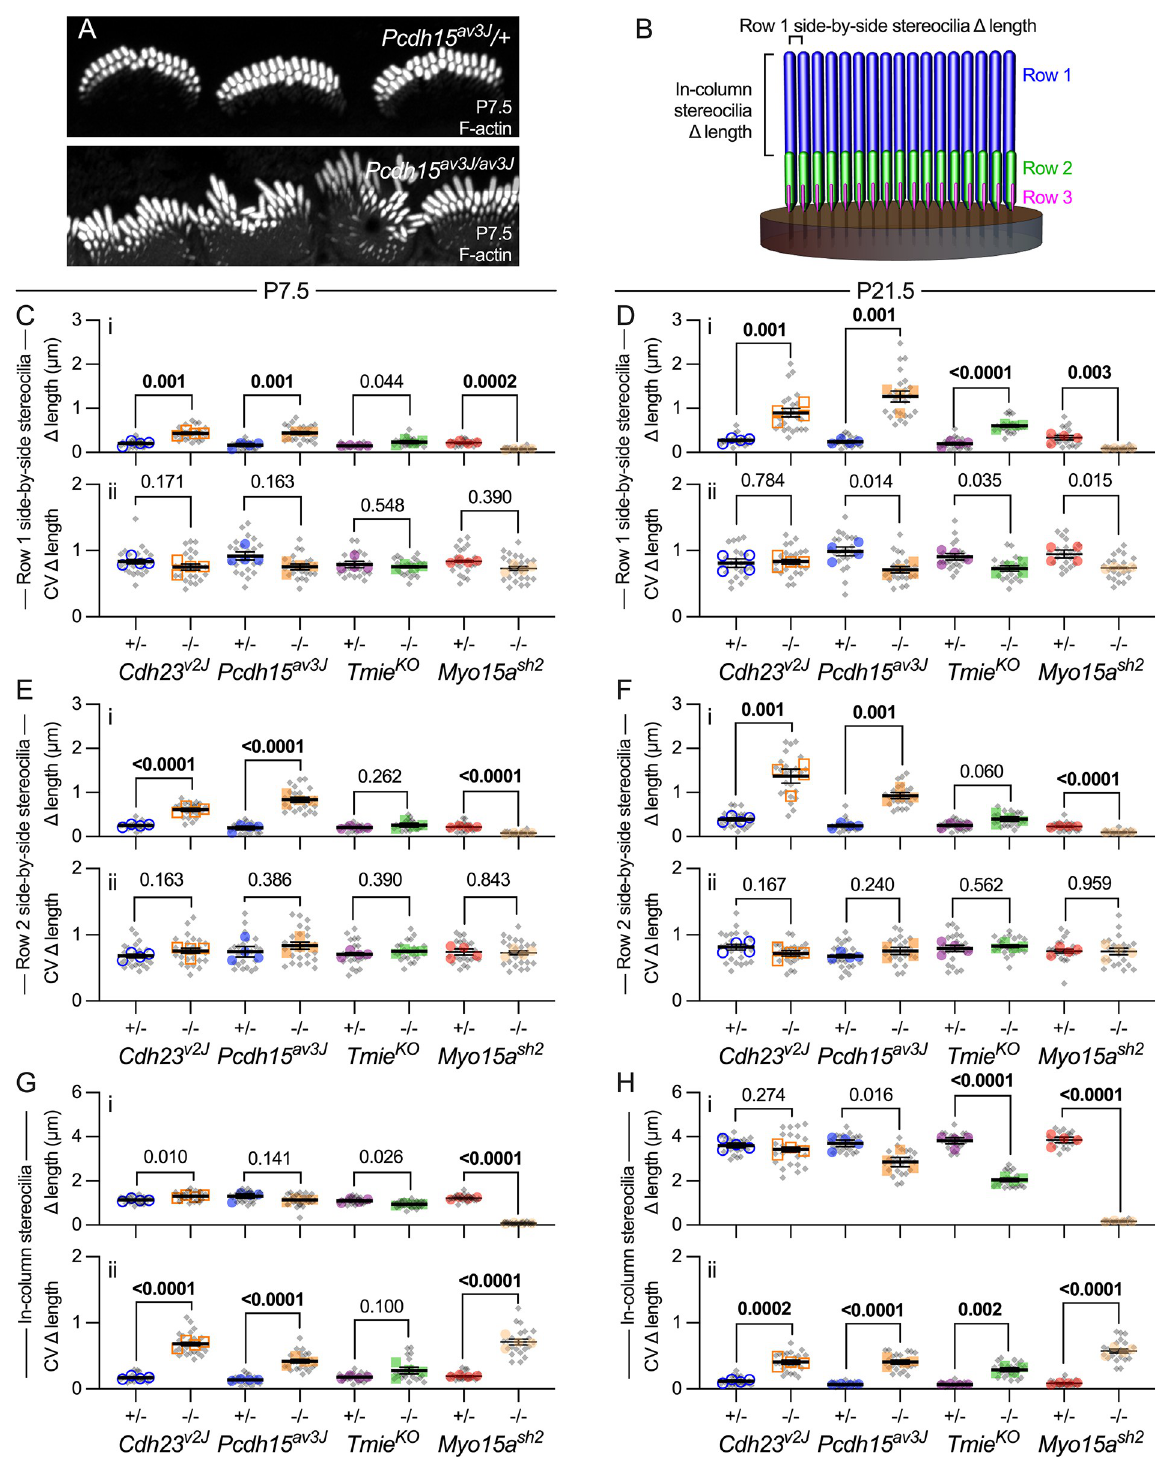
Fig 5. Adjacent stereocilia length coordination in mutants. ( A ) Phalloidin-labeled stereocilia from P7.5 Pcdh15 av3J IHCs. Adjacent stereocilia in homozygous mutant hair bundles are irregular in length. Panel widths: 30 μ m. ( B ) Schematic showing measurements made. For each pair of adjacent stereocilia in row 1 and, separately, in row 2, we measured the difference in length between them (side-by-side stereocilia Δ length). For example, Δ length for the pair indicated in panel B would be |length 1 –length 2 |, or the absolute value of the difference in lengths. In addition, for each row 1 –row 2 pair in a column, we measured the difference in length between the 2 stereocilia (in-column stereocilia Δ length).